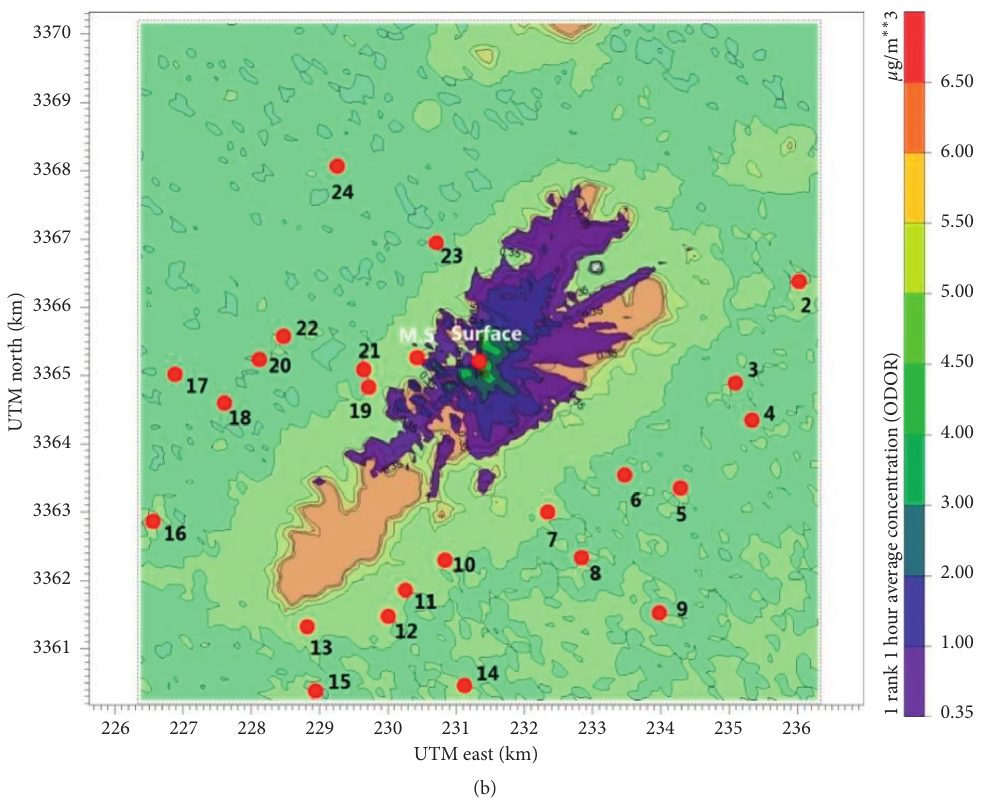
Figure 6: The comparison of H 2 S-influenced area sizes with different gas emission rates (surface denotes the landfill working area and the origin of odor emission; MS denotes the meteorological station in the landfill). (a) The H 2 S-influenced area with the original emission rate on the site (0.125kg/h). (b) The H 2 S-influenced area with the reduced emission rate on the